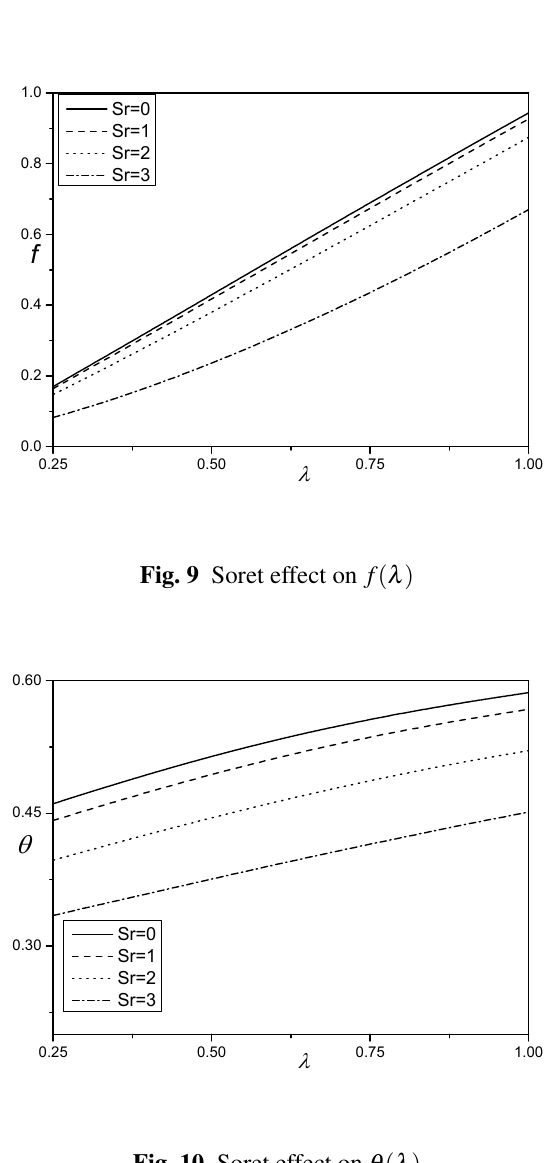
Fig. 10 Soret effect on θ ( λ